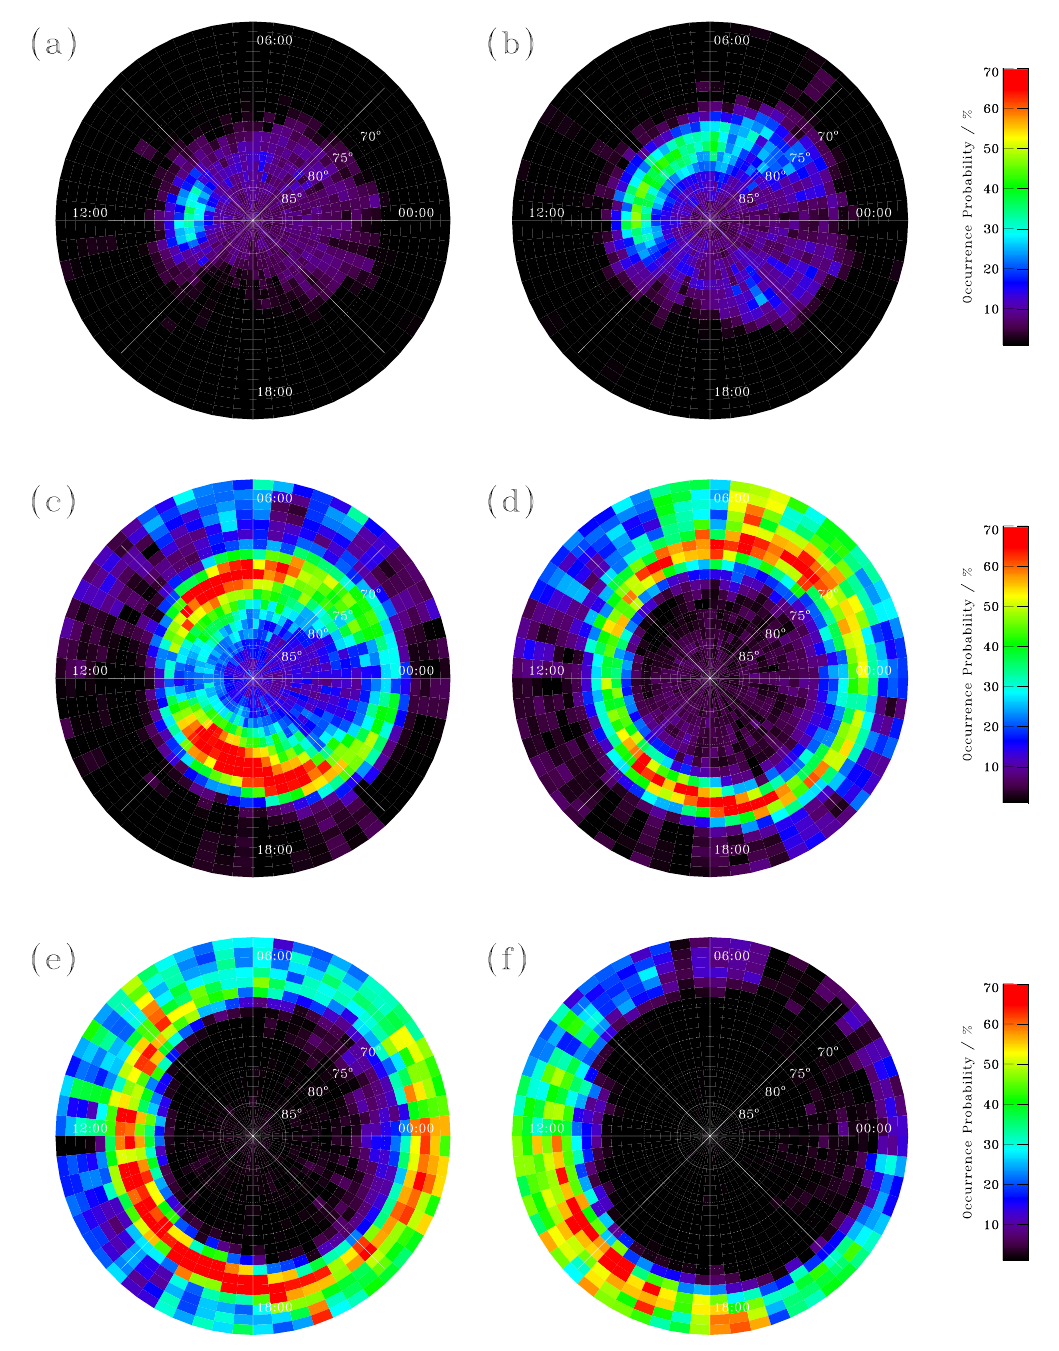
Fig. 3. The occurrence probability of average ion energies: (a) 0.9–1.53keV, (b) 1.53–2.10 keV, (c) 2.10–4.85keV, (d) 4.85–8.55keV, (e) 8.55–15.20keV and (f) 15.20–26.83keV. In each integration period, the average energy of ions between 0.9 and 30.9keVe detected by the DCR channel is determined. (Average ion energy <E> = F E /F .) These occurrences are plotted as a function of MLAT and MLT of the footpoints of T01 model field lines mapped from POLAR. Otherwise, data is presented in the same format as Fig.